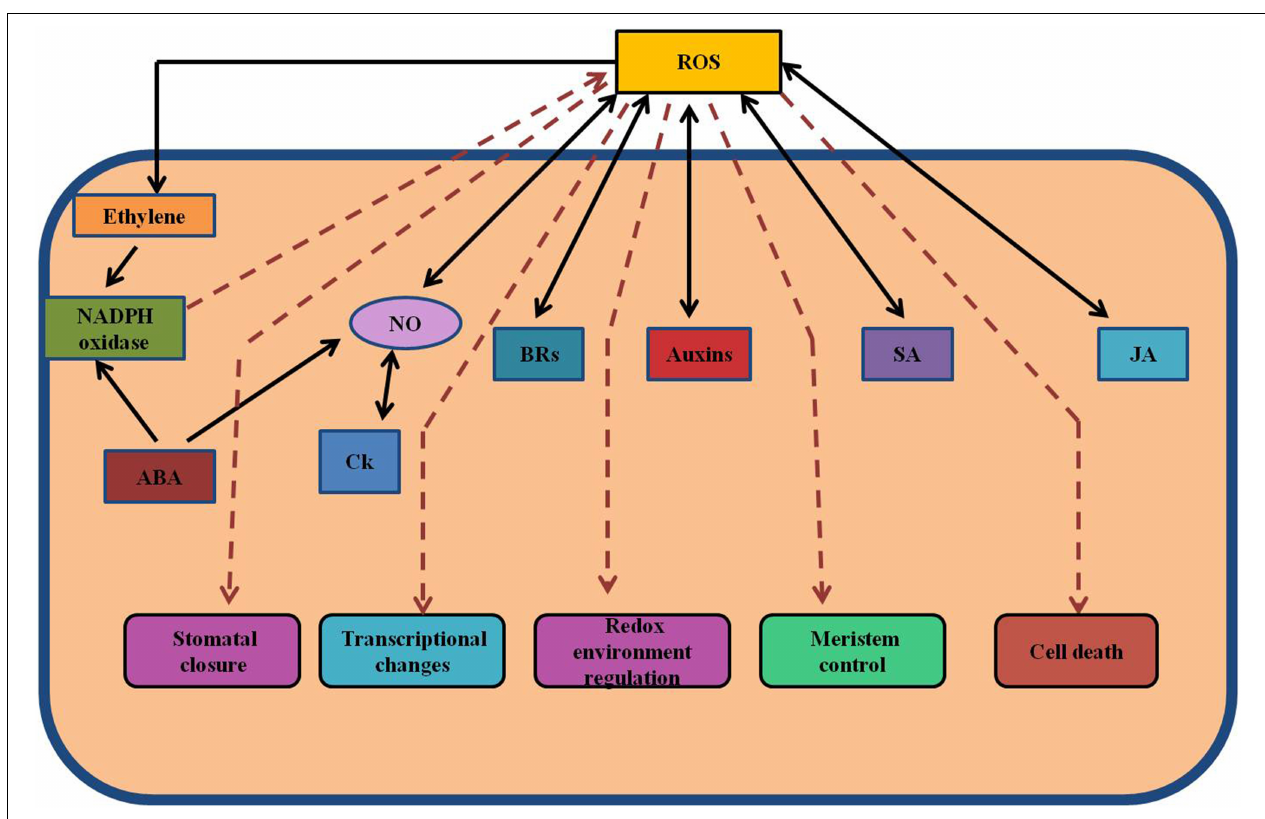
FIGURE 3 | Cross-talk between hormones and ROS during regulation of redoxenvironment. Variousspatialandtemporalchanges inthelevelsofROS and hormones at various organizational levels are important in operation of regulatory network. The concentration-dependent effects of ROS and their